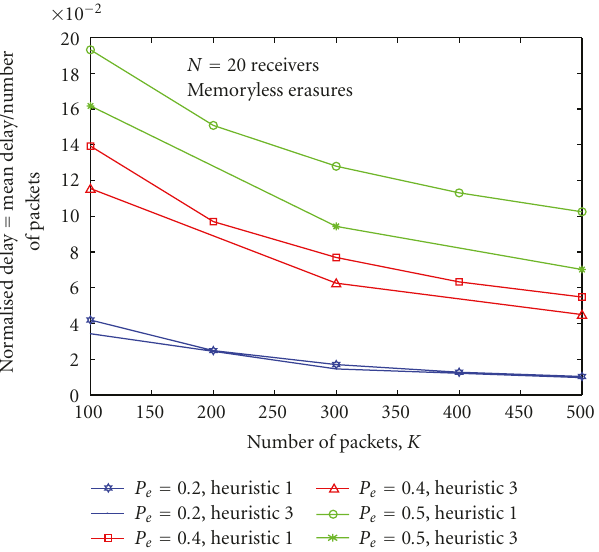
Figure 7: The e ff ect of number of packets and erasure probabilities on the normalized delay. The maximum number of recursions for Heuristic 3 is set to 100. As the erasure probability decreases, the delay decreases as expected. The normalized delay decreases with K for this particular N (this is not always the case).